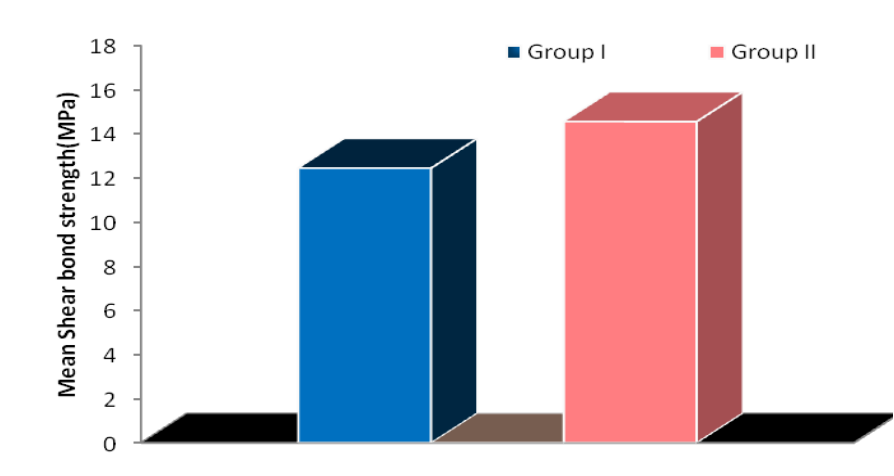
Fig. 6. Bar diagram depicting comparisons of difference in mean shear bond strength between two groups(Group I and II).